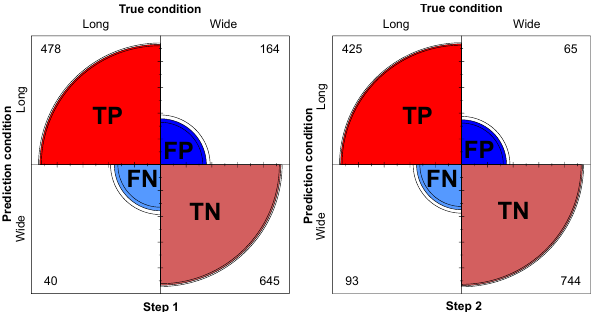
Figure 10. ROC curves for the two steps of the algorithm, their 95% confidence interval and the AUC